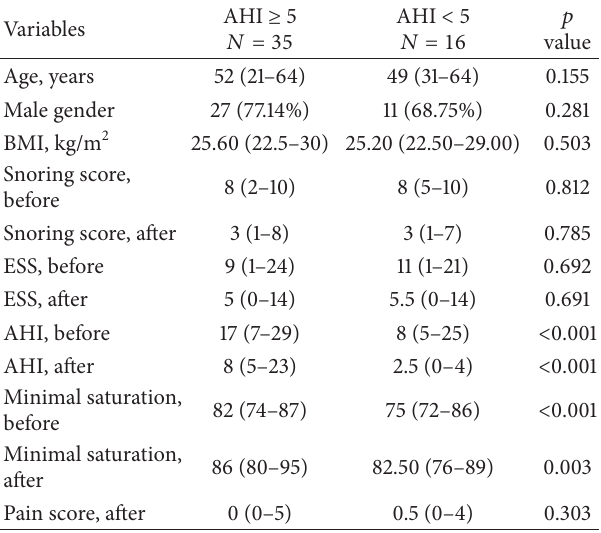
Table 2: Clinical features of obstructive sleep apnea patients who underwentradiofrequencytherapycategorizedbytheposttreatment apnea hypopnea index (AHI).